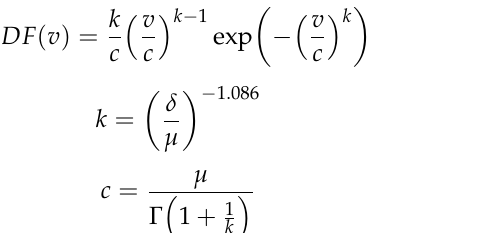
Figure 1. The structure of the proposed system.